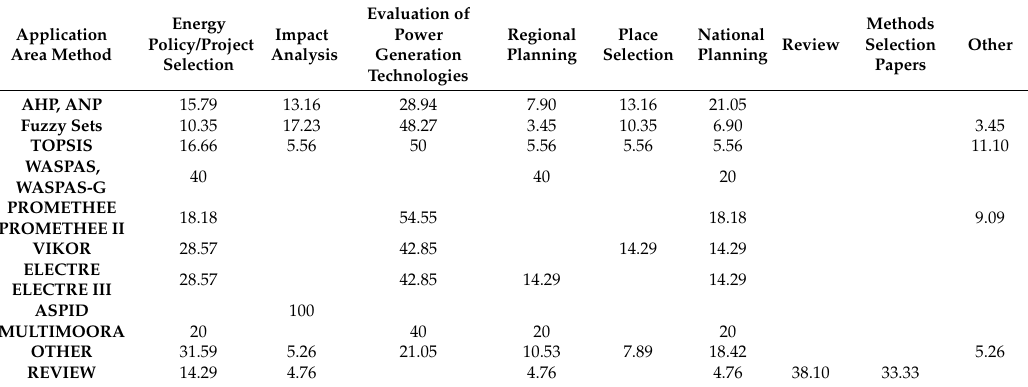
Table 6. The distribution of application areas by method,